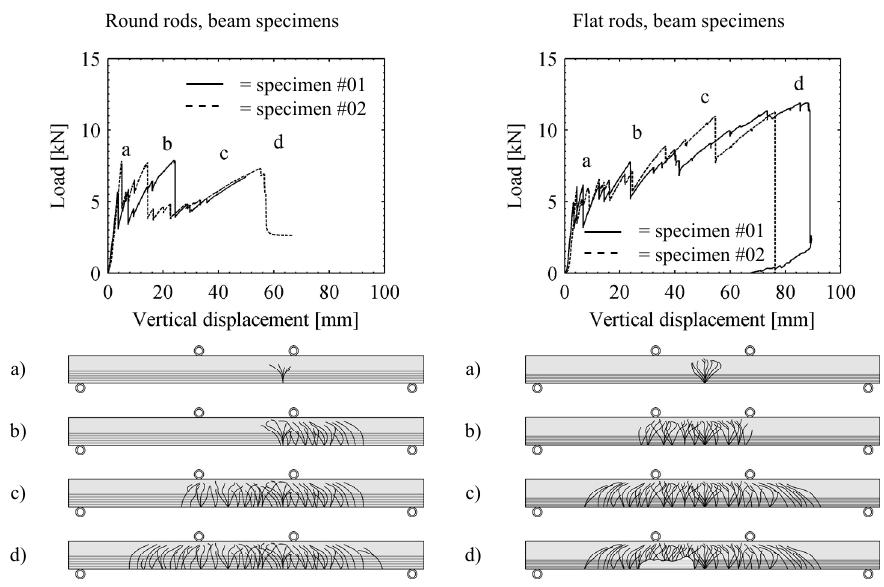
Figure 4: Load-displacement diagrams (up) and cracking sequence (below) of the beam specimens.